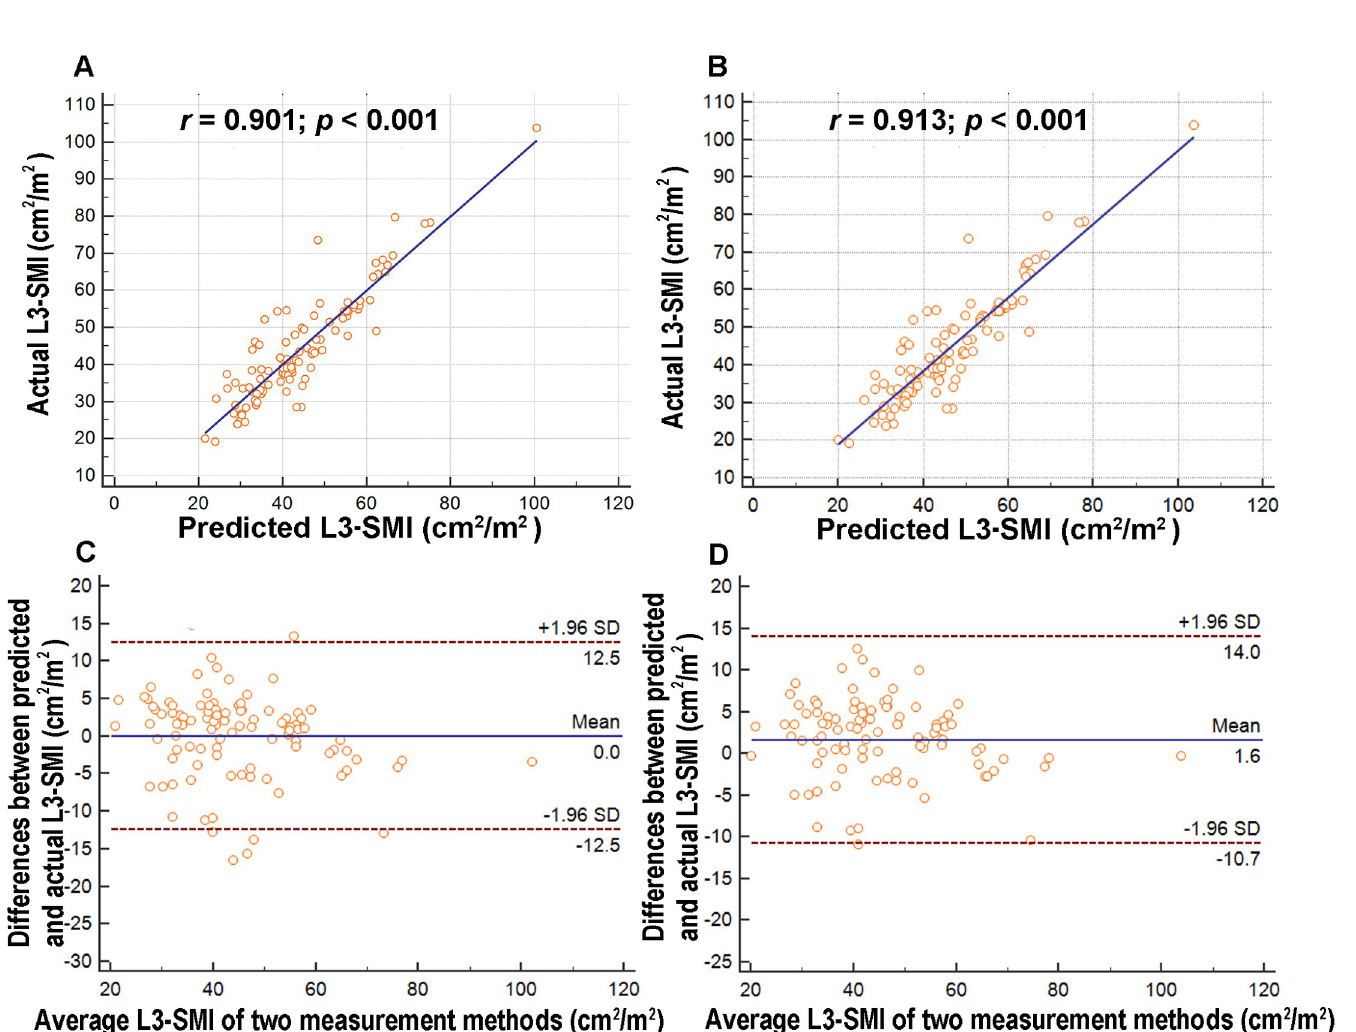
Fig 2. Analysis of L3-SMI estimates obtained using the M-SMI only and using the multivariate model. A significant correlation was observed between the L3-SMI measurements and predictions in (A) the univariate model and (B) the multivariate model. Bland–Altman plots exhibited reasonable agreement in the (C) univariate and (D) multivariate models. L3 = third lumbar vertebra; M-SMI = masticatory skeletal muscle index; SD = standard deviation; SMI = skeletal muscle index.